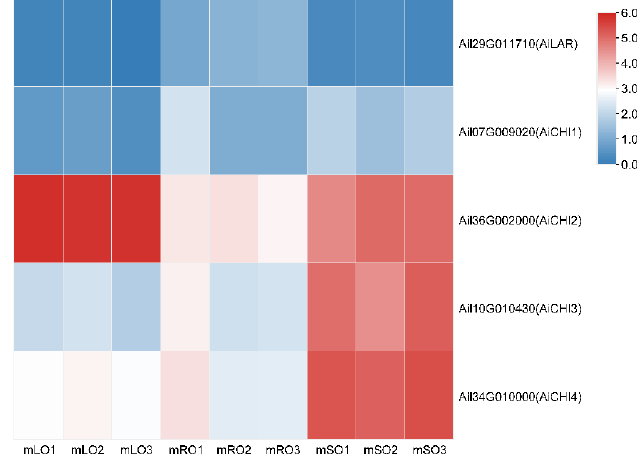
Figure 6. Expression heatmap of flavonoid synthesis-related differentially expressed genes in A. ilicifolius mature tissues. mOR, mOS, and mOL represent mature roots, mature stems, and mature leaves, respectively. The differential expression of genes in the heatmap are treated with log2.